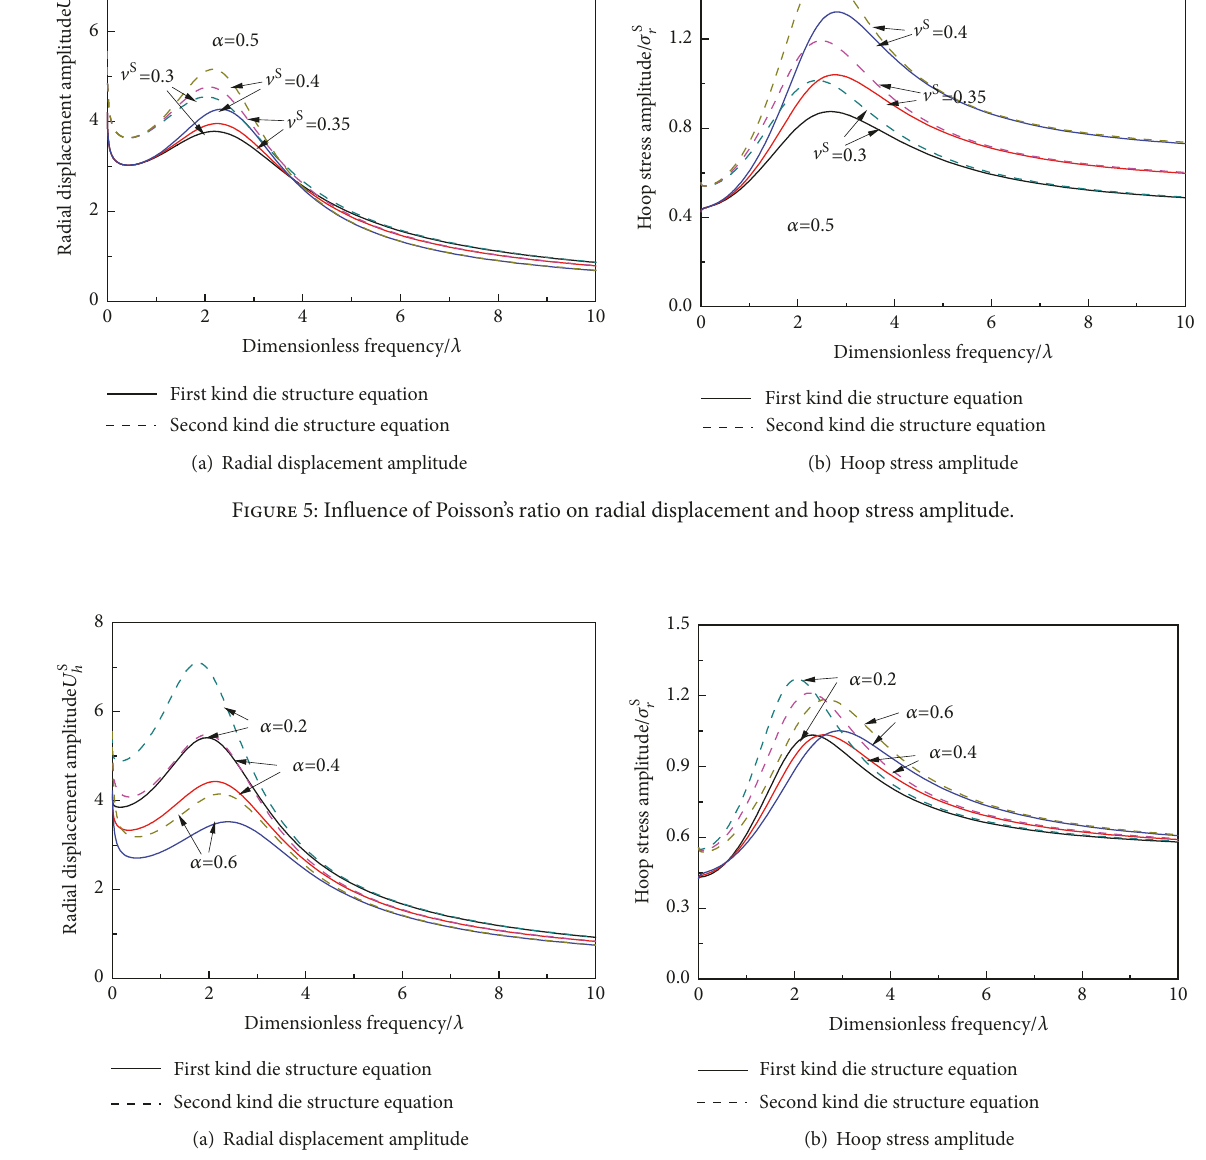
Figure 6: Influence of order on radial displacement and hoop stress